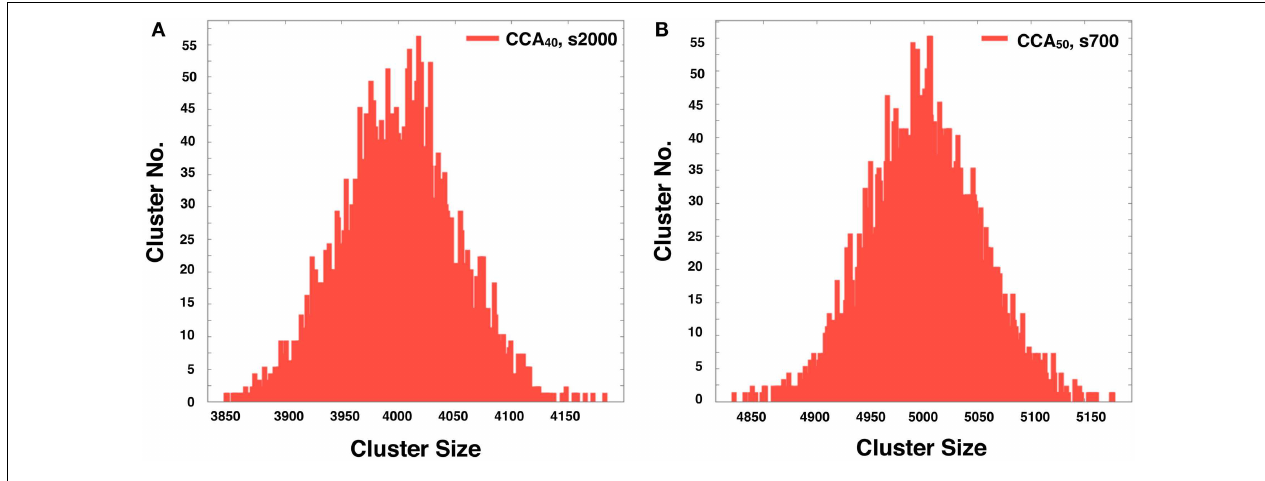
equal the theoretically derived value of each model (4,000 was the peak of the histogram of CCA 40 ; 5,000 was the peak of the histogram of CCA 50 ).